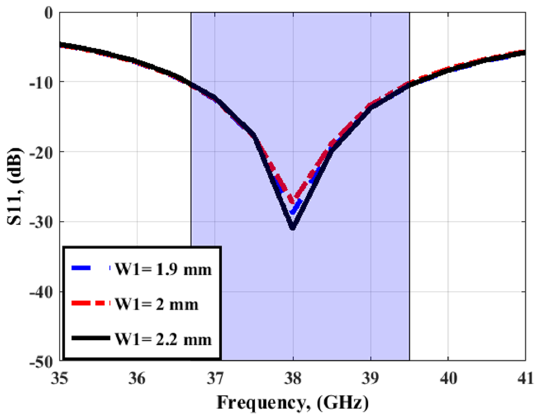
Figure 3. The W1 effect on the antenna performance.